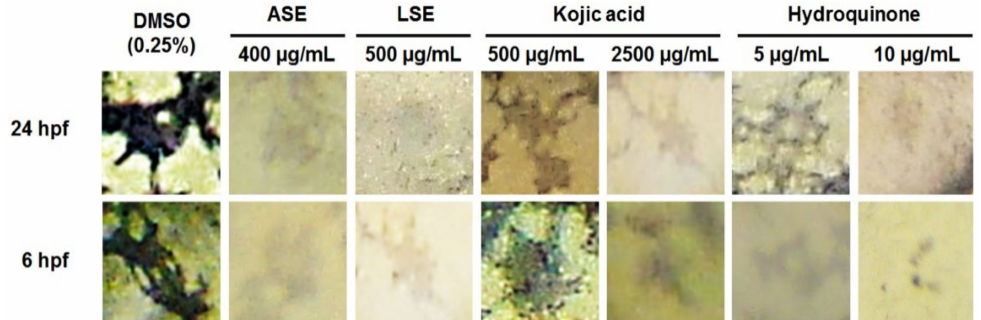
Figure 3. LSE and ASE are not toxic to melanocytes in vivo at the depigmenting doses. The inhibition of melanin synthesis and melanocytotoxicity were addressed in zebrafish embryos exposed to both extracts, i.e., kojic acid or hydroquinone at 6 hpf and 24 hpf. Melanocytes fading and non-changed morphology was observed in the treatments with ASE, LSE, and kojic acid, indicating the inhibition of melanin synthesis, while hydroquinone applied at 6 hpf exerted cytotoxic effects, manifested as the rounding of stellate melanocyte and the loss of their dendrites.